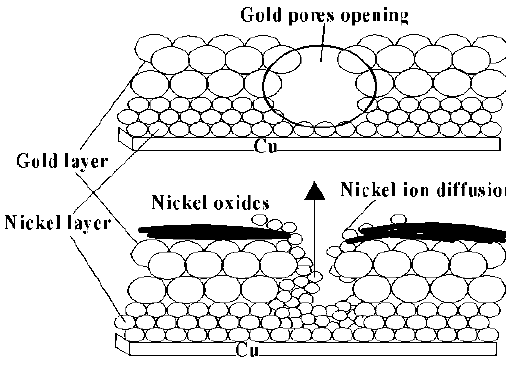
Figure 13. Schematic of the TH failure mechanism in electroless nickel and immersion gold plating (ENIG) surface finish.